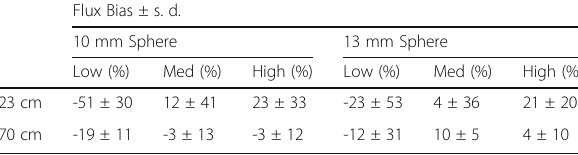
Table 1 (abstract A21). Bias ± s. d. values of measured flux across 20 replicates using PMOD. Results show improved accuracy of flux ( K 1 ∗ k 3/( K 1+ k 2)) and precision for the 70 cm scanner by a factor of 2-3 x Flux Bias ± s. d.